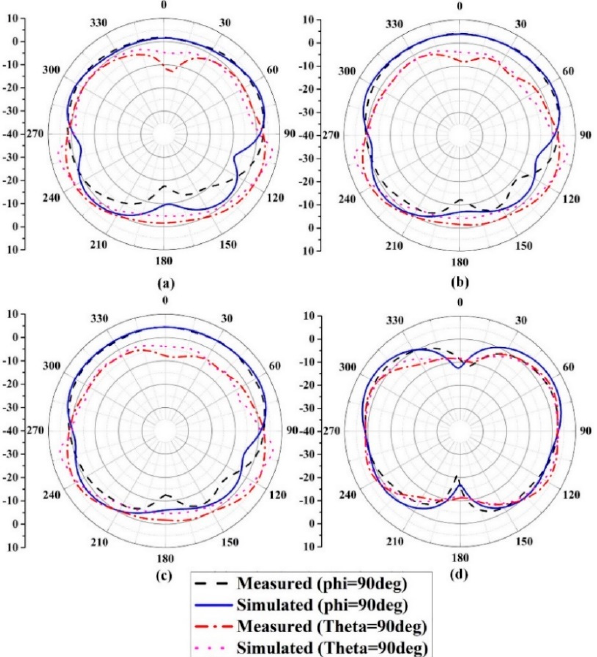
Figure 9. The simulation and test radiation patterns in the yoz plane (phi=90degree) and xoy plane (theta=90degree) at 5.5 GHz of the proposed eight-element MIMO excited separately by various antennas. ( a ) Ant 1; ( b ) Ant 2; ( c ) Ant 3; ( d ) Ant 4.